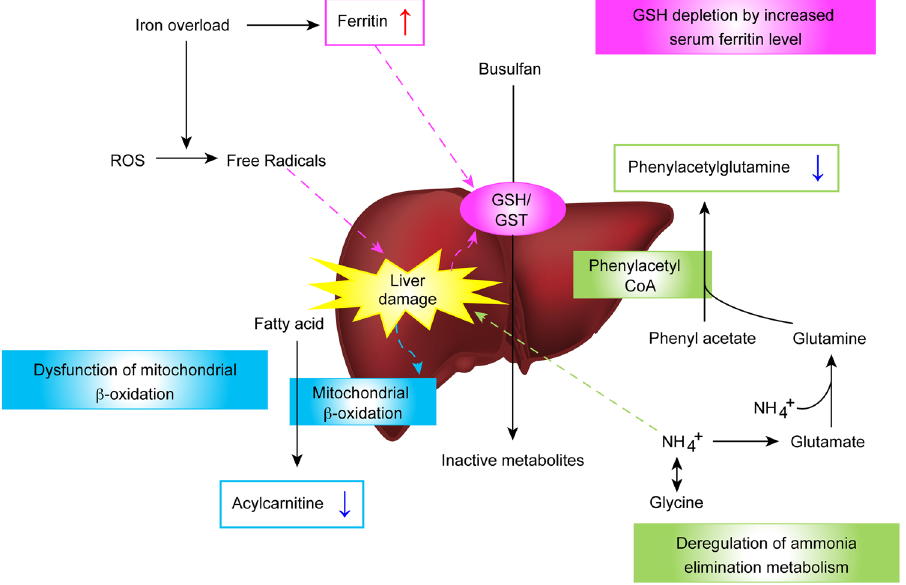
Figure 5. Potential mechanism for busulfan overexposure, including liver damage related